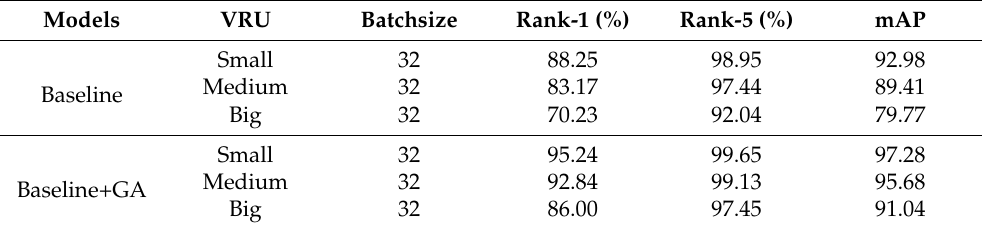
Table A1. Test results of the baseline model and the global attention model with input batch 32 on the VRU dataset.